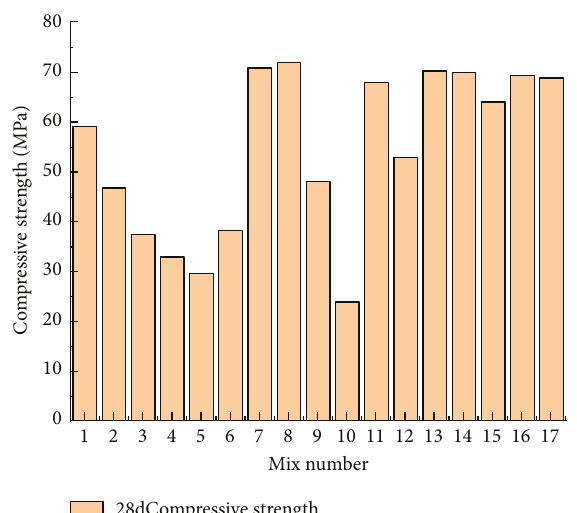
Figure 5: Compressive strength of specimens with different mixing ratios.